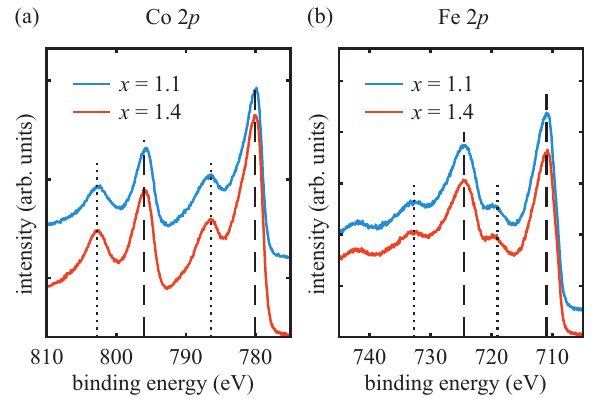
Figure 2. Angular integrated ( a ) Co 2 p and ( b ) Fe 2 p HAXPES spectra for both samples. In both spectra, the dashed lines indicate positions of the particular 2 p 1/2 and 2 p 3/2 peaks. The dotted lines correspond to positions of the shake-up satellites in ( a ) and the charge-transfer satellites in ( b